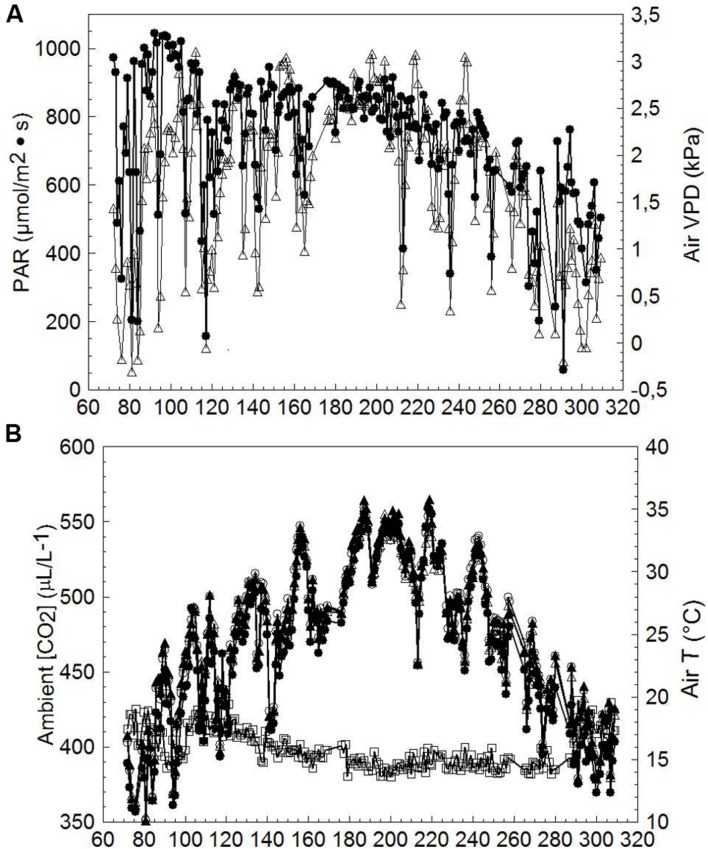
Seasonal trends of incoming photosynthetically active radiation (PAR, ●), air vapor pressure deficit (VPD, △) (A), inlet chamber air temperature (T, ●), outlet chambers air temperature for SWP (T, ∘), outlet chambers air temperature for LWP (T, ▲), outlet chambers air temperature for VLWP (T, △) and ambient CO2 concentration (□) (B) measured at the trial site. Values are daily means averaged from dawn to dusk.